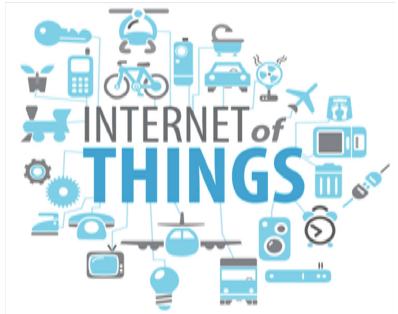
Figure 1: Internet of Things general